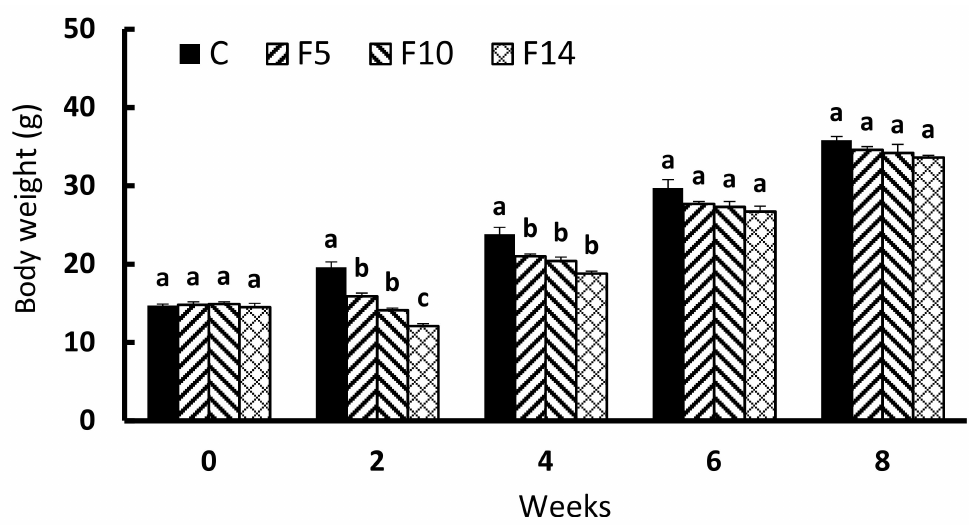
Figure 1. Changes in body weight of juvenile leopard mandarin fish ( Siniperca scherzeri ) subjected to four feeding regimens across an 8-week trial: Control (C), fish fed continuously; F5, fish fasted for 5 days (days 10–14); F10, fish fasted for 10 days (days 5–14); and, F14, fish fasted for 14 days (days 1–14), prior to all fasted fish being fed to satiation. Values (mean ± standard error, n = 5 in weeks 0 and 2, n = 3 in weeks 4, 6 and 8) in the same column with dissimilar letters are significantly different ( p <